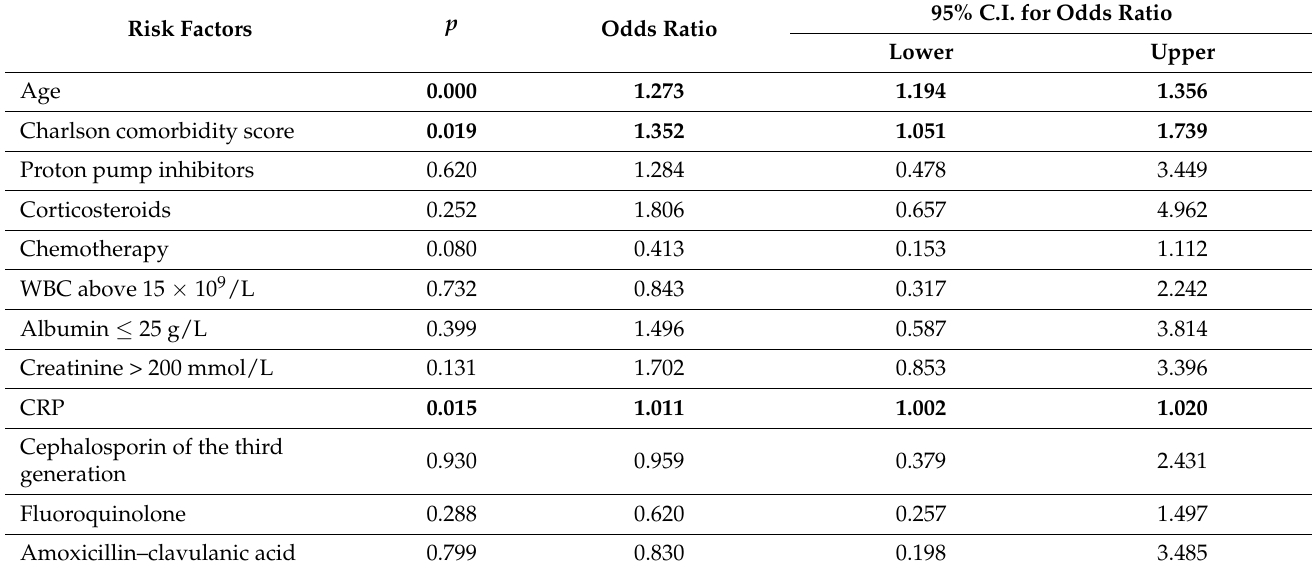
Table 5. Predictors of the lethal outcome in the group of patients coinfected with CDI and